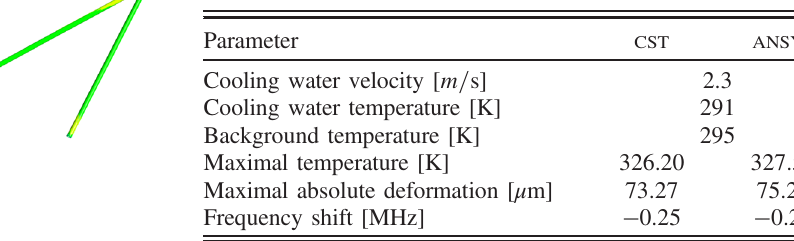
TABLE VIII. Comparison of the thermal and structural analysis results between CST and ANSYS .